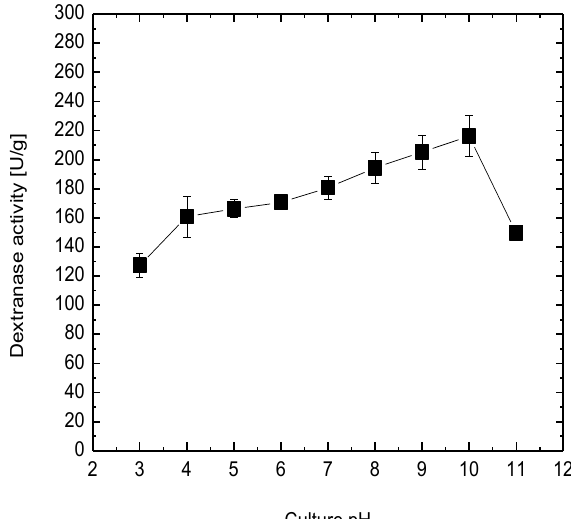
Figure 4. Effect of different pH on dextranse production from Bacillus subtilis NRC-B233b